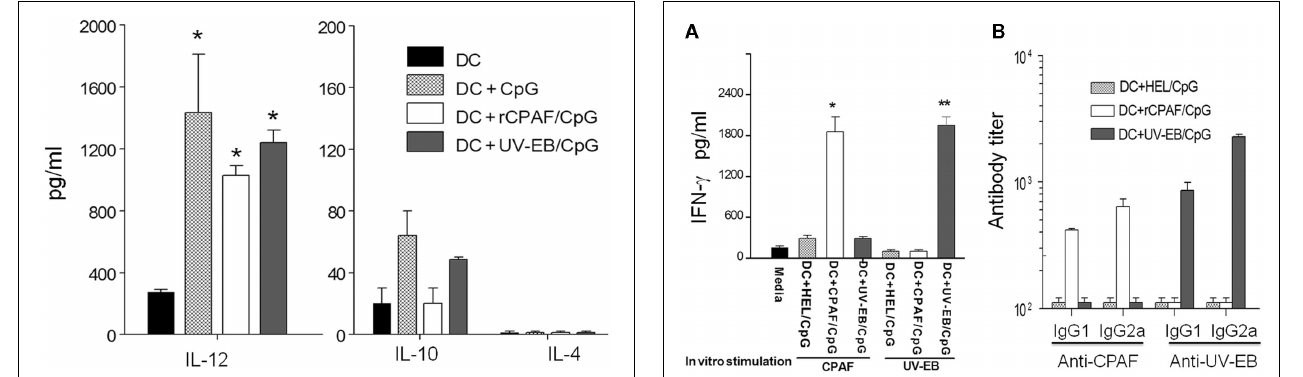
FIGURE 4 | Immune response following subcutaneous vaccination using BMDCs pulsed with HEL + CpG, rCPAF + CpG, UV-EB + CpG. (A) Induction of antigen-specific IFN- γ . Groups (three mice per group) were immunized s.c. on day 0 with BMDCs pulsed with HEL + CpG, rCPAF + CpG, or UV-EB + CpG. Fourteen days following initial immunization, splenic CD4 + T cells were purified, cultured with mitomycin-C treated APCs, stimulated in vitro with rCPAF or UV-EB, and IFN- γ production into the supernatant measured by ELISA.The mean ± SEM per group is shown. Significant differences ( p ≤ 0.05; ANOVA) between the ( ∗ ) CPAF + CpG group and BMDCs pulsed with HEL + CpG or UV-EB + CpG group, ( ∗∗ ) between the UV-EB + CpG group and BMDCs pulsed with HEL + CpG, or rCPAF + CpG group are shown. (B) The level of antigen-specific antibody. Groups (six mice per group) were immunized s.c. on day 0 with BMDCs pulsed with HEL + CpG, rCPAF + CpG, UV-EB + CpG, and booster immunizations were given on day 14.The serum CPAF-specific and UV-EB-specific antibodies were measured 14days after the last booster immunization, and the mean ± SEM per group of the reciprocal titer corresponding to the 50% maximal binding is shown.The results are representative of two individual